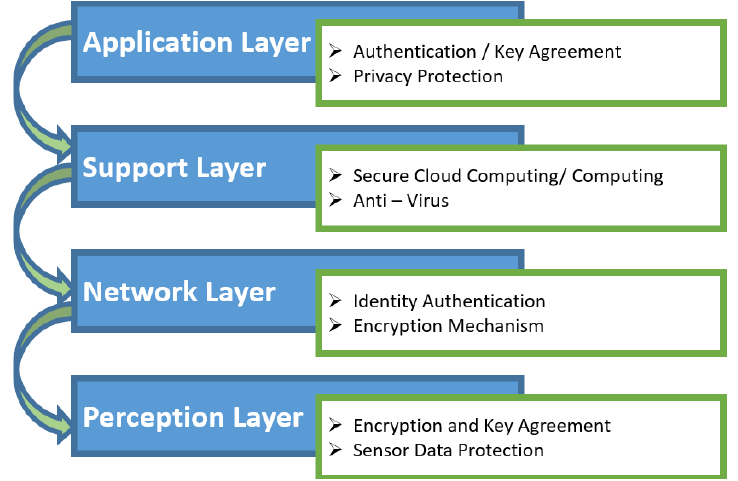
Figure 5. The four-layered architecture of IoT along recommended security